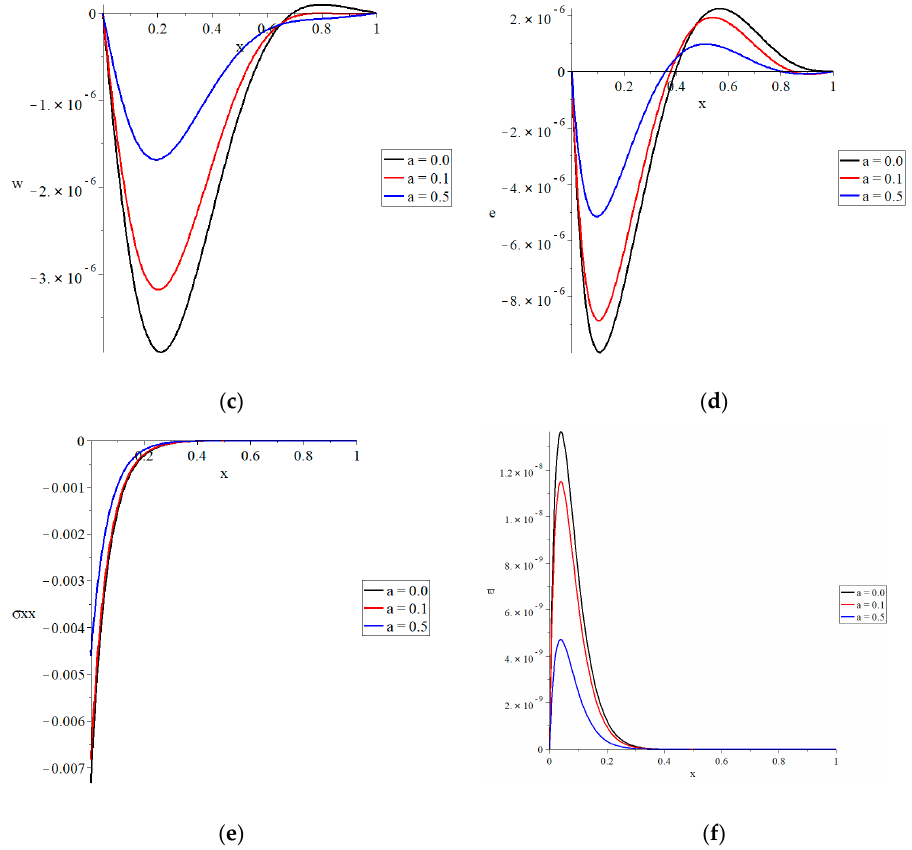
Figure 4. The distributions with variance values of the two-temperature parameter when β = 1.0, t 0 = 1.0. ( a ) The distribution of conductive temperature, ( b ) the distribution of dynamical temperature, ( c ) the distribution of lateral deflection, ( d ) distribution of strain, ( e ) the distribution of stress, ( f ) the distribution of strain energy density function. Figure 5 represents the conductive and dynamical temperature, lateral deflection, and strain, stress, and strain energy density function distributions for three different values of the beam’s thickness z = ( h /5, h /4, h /3 ) when β = 1.0, t 0 = 1.0, and a = 0.5, respectively. The thickness of the beam has a substantial effect on the conductive and dynamical temperatures, as well as the strain, stress, and strain energy density function distributions, but it has no impact on the lateral deflection, which is unaffected by the variable z . The values of the conductive and dynamical temperatures, absolute values of the strain, absolute values of the stress, and strain energy density function all rise as the thickness of the beam